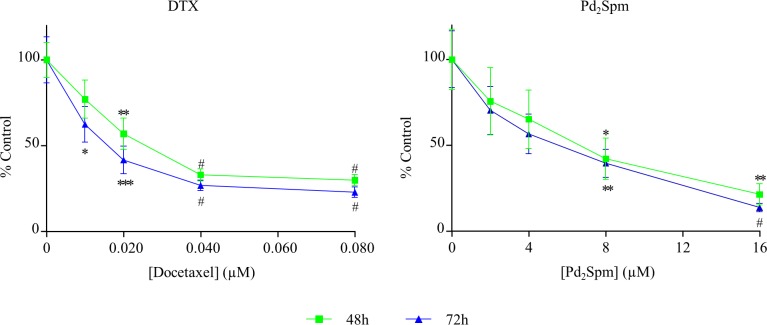
Antiproliferative effect for the MDA-MB-231 cell line upon exposure to Pd2Spm and DTX.Simple proliferation of MDA-MB-231 cells:–treated with either DTX (1-8x10-2 μM) or Pd2Spm (1–16 μM), in sole administration. The results are expressed as a percentage of the control ± SEM. The one-way ANOVA statistical analysis was used, and the Dunnett’s post-test was carried out to verify the significance of the obtained results (*p<0.05, **p<0.01, ***p<0.001, #p<0.0001 versus the control, for the same time-points).